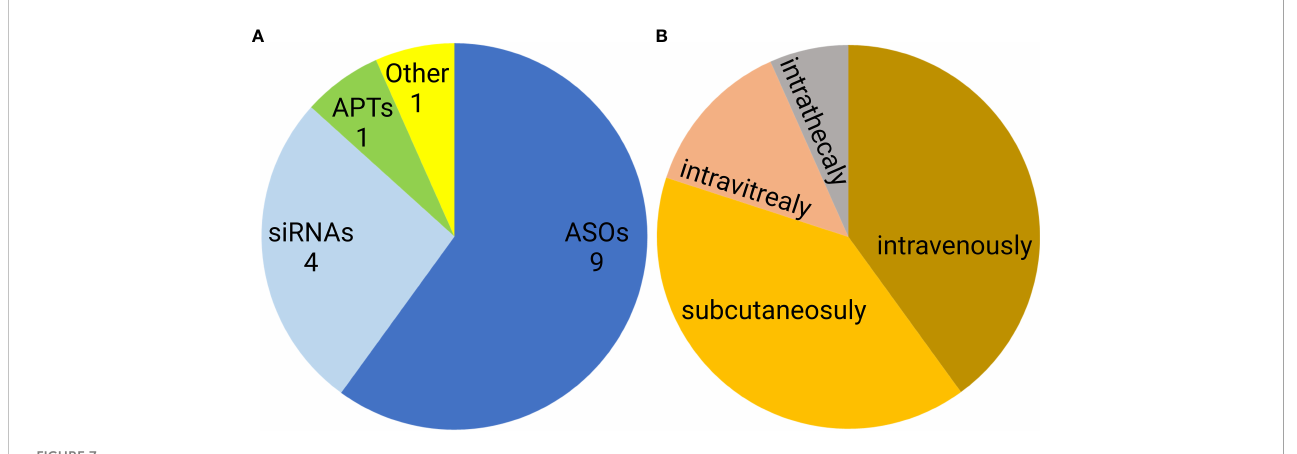
FIGURE 7 Distribution of FDA approved noncoding nucleic acid therapeutics according to type (A) and route of administration (B) . ASO- antisense oligonucleotides, siRNAs- small interfering RNAs, APTs-